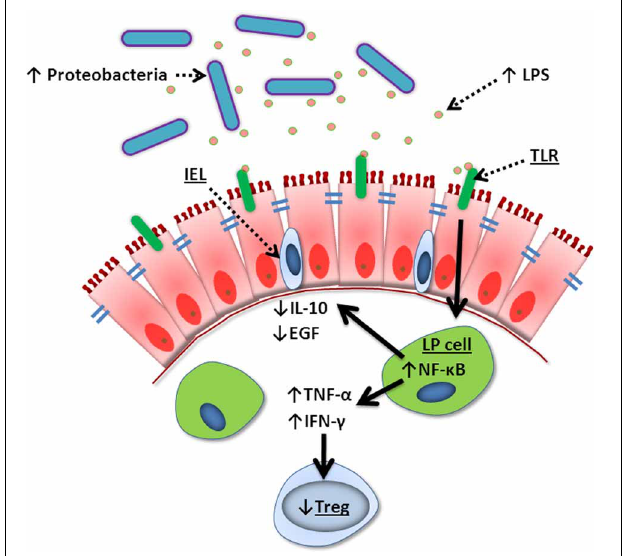
FIGURE 4 | Summary of TPN-induced epithelial signaling changes. Lack of enteral nutrition leads to a change in luminal microbiota where Gram-negative Proteobacteria dominate. Lipopolysaccharide (LPS) derived from these bacteria signal lamina propria (LP) cells via Toll-like receptors (TLR), leading to increased NF- κ B transcription. This creates a pro-inflammatory state with increased TNF- α and IFN- γ , loss of T reg cells, and decreased intraepithelial lymphocyte (IEL)-derived IL-10 and EGF. These changes lead to break down of tight junctions, loss of epithelial barrier function, bacterial translocation, and